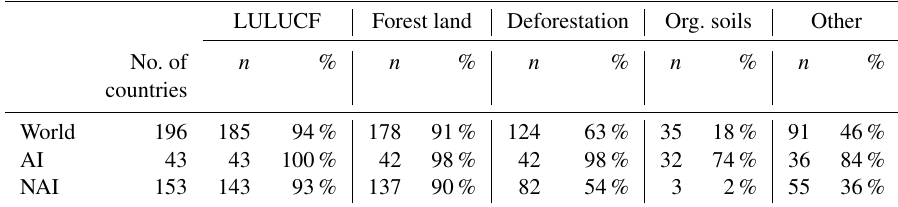
Table 4. Statistics on land use categories reported in NGHGIs and used in this study. The % refers to the share within the categories (world, AI, or NAI